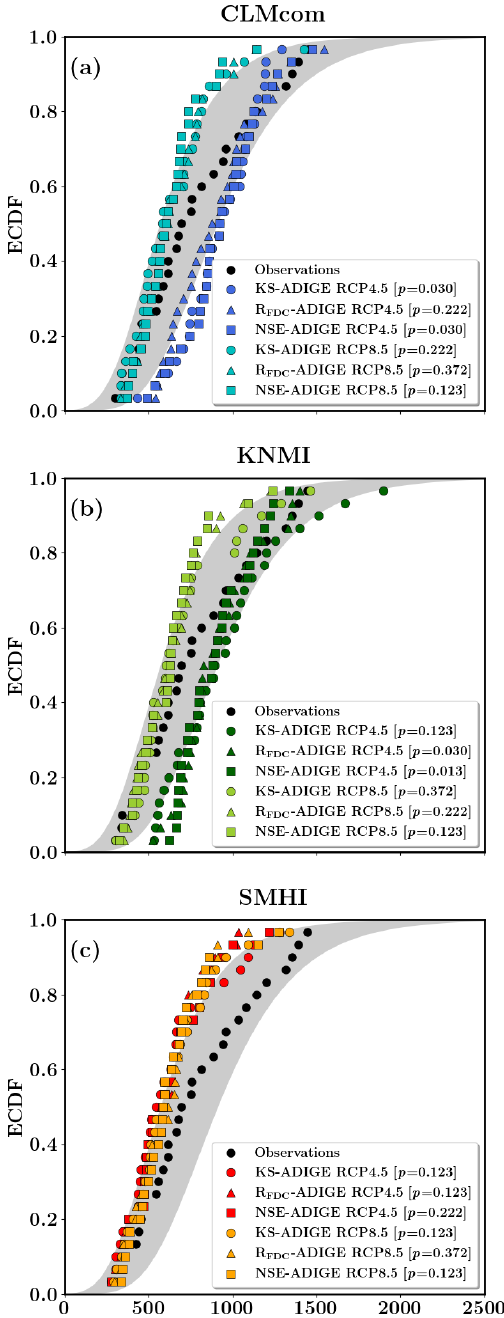
Figure 4. ECDFs of the annual maximum streamflow at the Trento gauging station during the 1982–2010 period obtained using the NSE-ADIGE, KS-ADIGE and R FDC -ADIGE parameterizations and the (a) CLMcom, (b) KNMI and (c) SMHI climate models as input forcing for both the RCP4.5 and RCP8.5 emission sce- narios. The experimental ECDF is shown with black dots, and the gray shaded area indicates the associated 90% confidence interval of the fitted Gumbel distribution. The p values of the Kolmogorov– Smirnov two-sample test are also reported in brackets for each sim- ulation